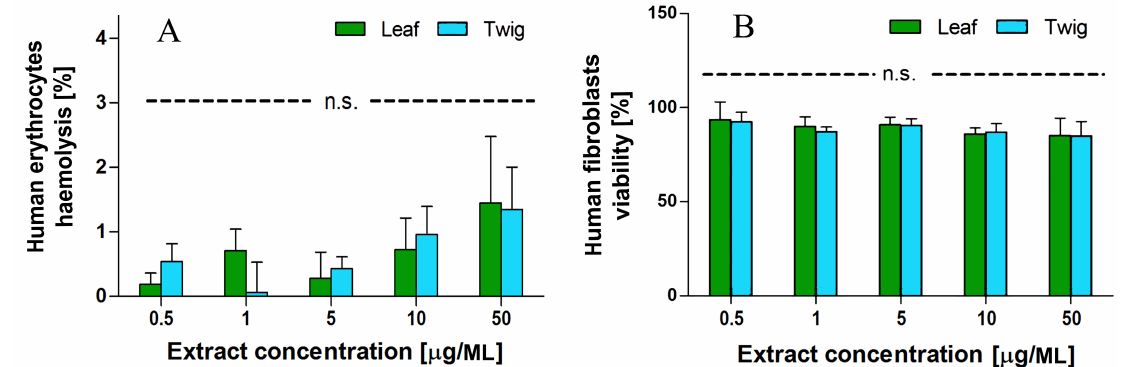
Figure 3. Hemolysis of human erythrocytes ( A ) and human fibroblasts viability ( B ) after 24 h incubation with the leaf and twig extracts of R. canina . Data are mean ± SD ( n = 3). n.s.—not statistically significant, tested samples vs. non-treated control cells, p >